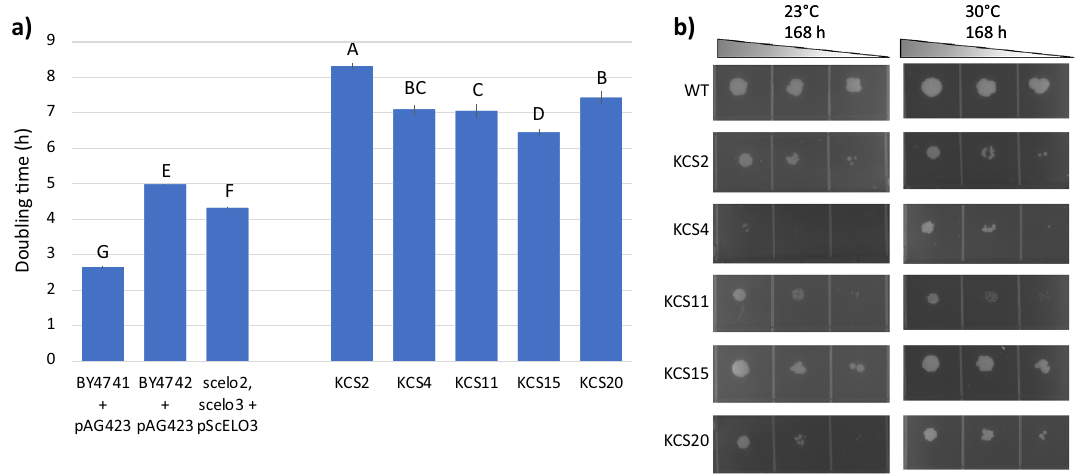
Figure 2. Growth of the ZmKCS complementing s trains . ( a ) Culture doubling time of the scelo2; scelo3 double mutant strain complemented by the expression of Zm KCS isozymes. Error bars represent standard error from 3 replicates, different letters above the data-bars indicate statically significant differences based on Student’s t-test ( p < 0.05). ( b ) Serial tenfold dilution inoculum of each indicated strain was applied on solid media, and growth was evaluated at 23 °C and 30 °C at the indicated times after inoculation. Images are representative from three repetitions of this experiment. Doubling time Time to mid-log phase Time to stationary phase Yeast strain Maximum OD600h SE BY4741 + pAG423